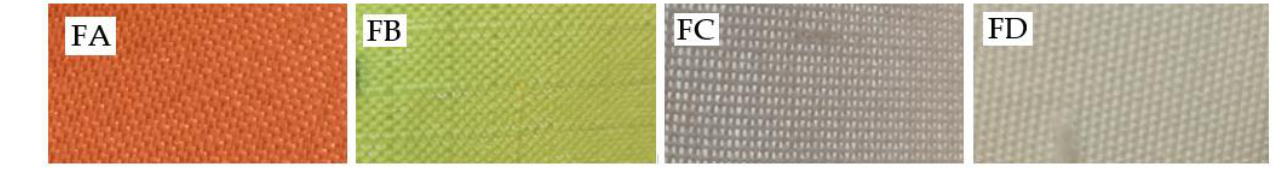
Figure 8. Fabrics used in experiments FA-orange, FB-light green, FC-light grey, and FD-colorless. The real samples (P1–P26) were collected from clothing. Most of them were fabrics made entirely of polyester or containing a predominance of polyester in the composition. A detailed description of the real samples tested is included in Table 7. Table 7. The real sample used in experiments.